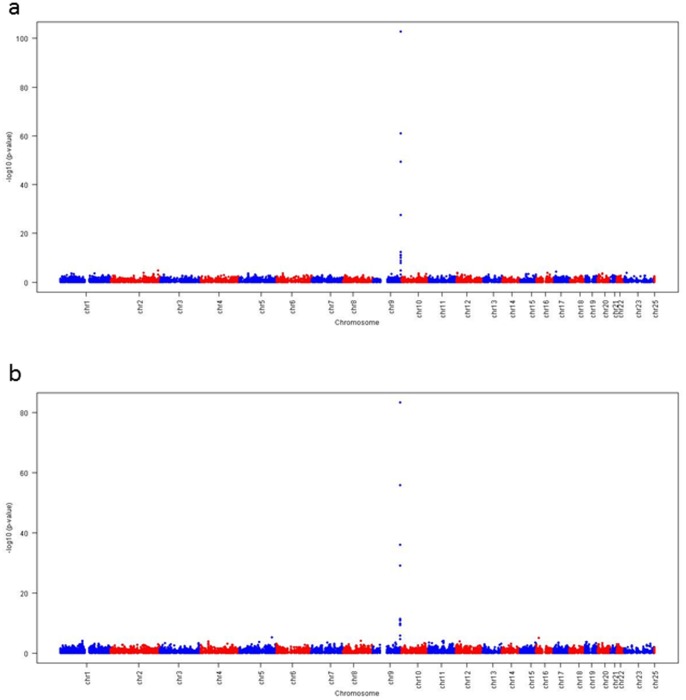
Manhattan plots for KORA (a) and LURIC (b).